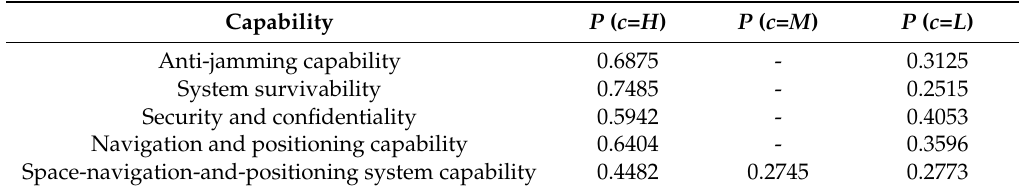
Table 6. The probability distribution of the requirement-satisfaction degree for each upper-layer capability.